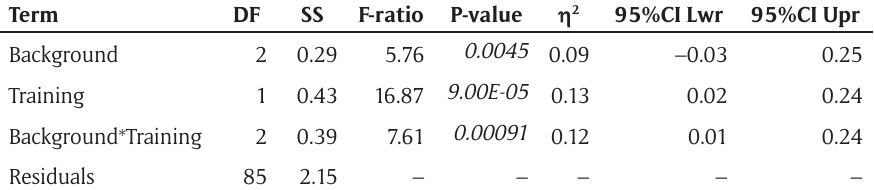
Table 1: ANOVA results comparing mean accuracy of photo identifications across participants based on biology background of participants and amount of training received.